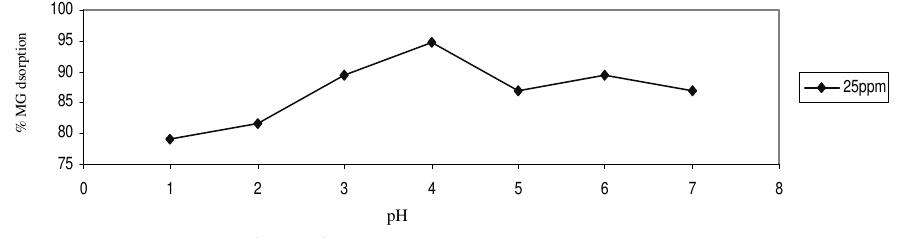
Figure 4 . Effect of pH on removal of MG dye